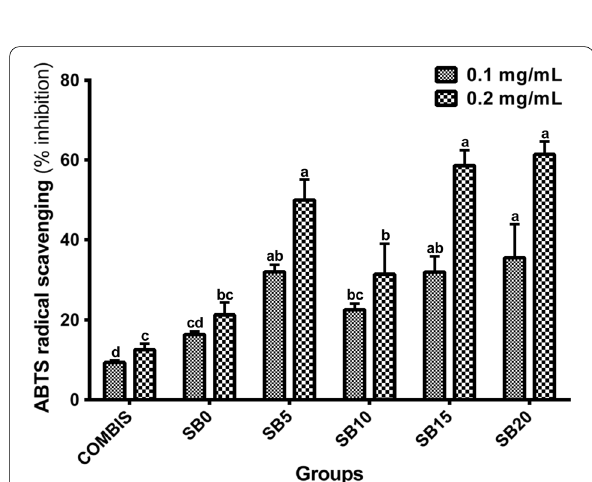
2.76 mg GAE/g (COMBIS) to 6.57 mg GAE/g (SB20). At 0.50 mg/mL concentration of biscuit extract, the total flavonoid content varied from 0.02 mg RE/g (COMBIS) to 0.09 mg RE/g (SB20). The increase in substitution